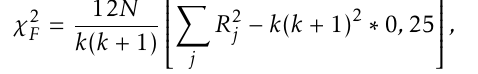
Algorithm 1: Pattern-based CSF Segmentation